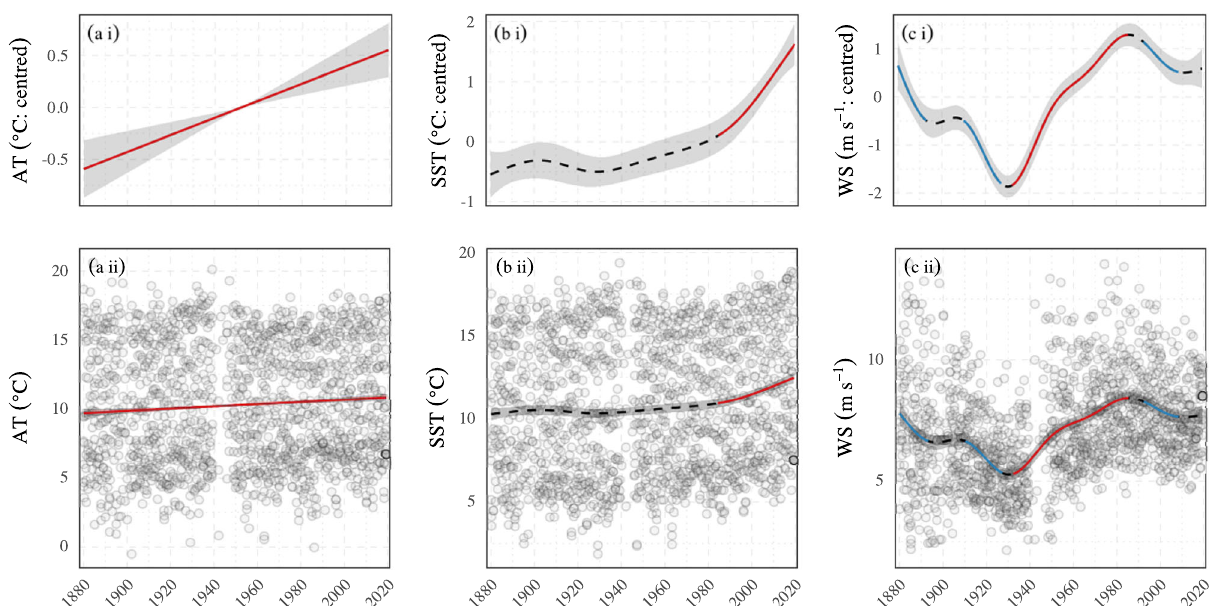
Fig. 3 Historical trends in temperature and wind speed on the Southern North Sea coast. Historical trends of a air temperature, b sea surface temperature, and c wind speed within the sampling region from 1880 to 2020. For each environmental parameter both the overall change including all individual data points ( a ii, b ii, c ii) and the temporal change centred around the maximum variability ( a i, b i, c i) are presented. Coloured lines mark periods of signi fi cant increase (red) or decrease (blue). 95% con fi dence intervals (shaded area) are reported for each predictor (dashed